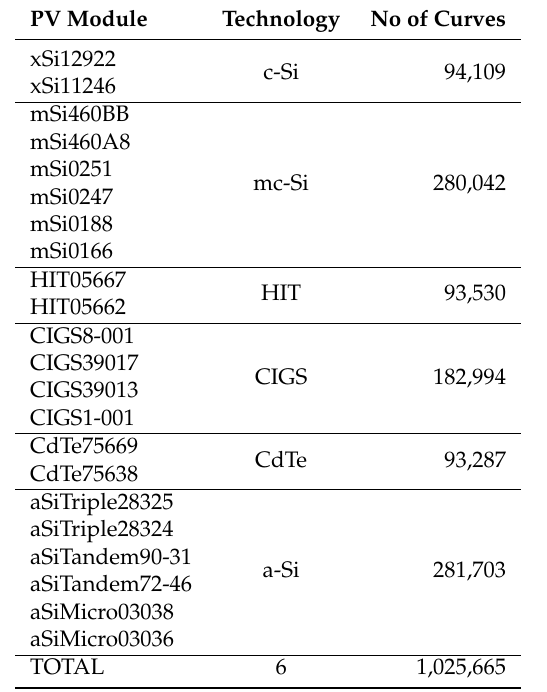
Table 2. Dataset of I-V curves used in the comparative assessment provided by NREL